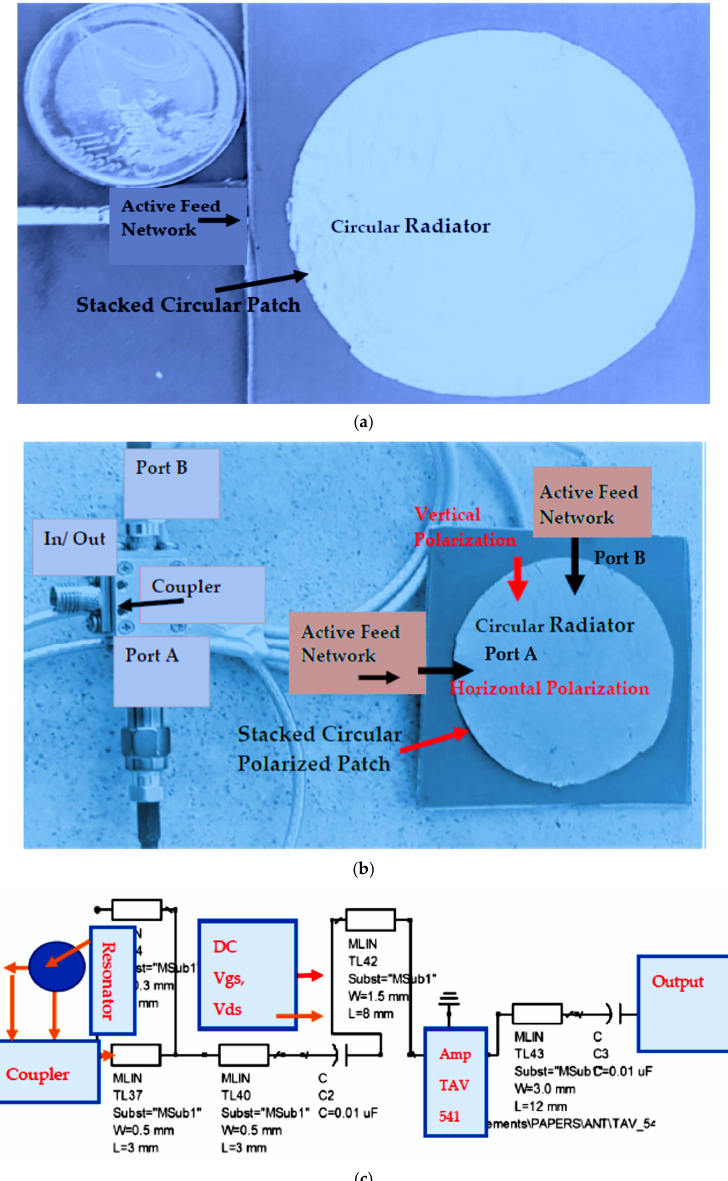
Figure 27. ( a ) Photo of the lab module of the Active Circular Stacked antenna ( b ) A photo of the lab module of the Active Circular Polarized patch ( c ) Layout of the Active Antenna modules